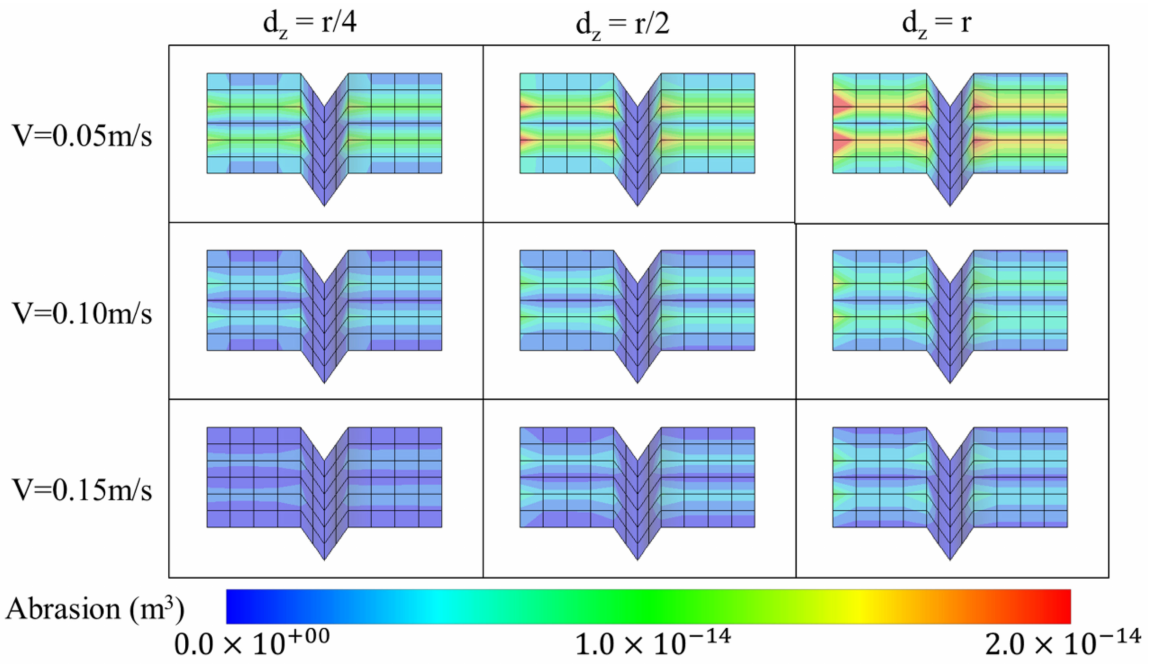
Figure 8. Abrasion distribution on tooth surfaces under various